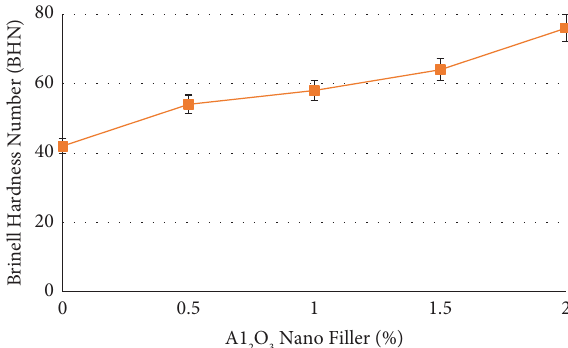
Figure 6: Hardness of epoxy hybrid composites.